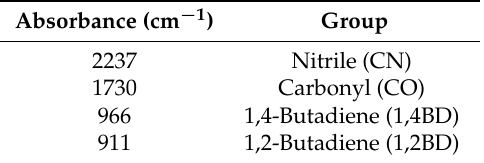
Table 2. Overview of relevant absorbances for the FTIR